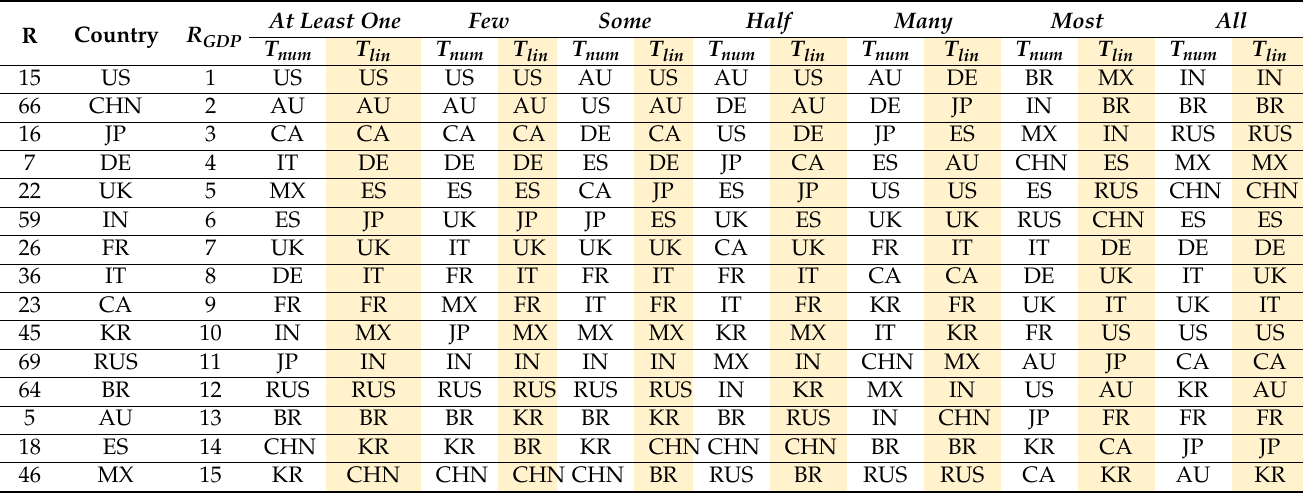
Table 12. Re-ranked QOLI of top 15 countries in GDP (number versus. 2-tuple value). At Least One Few